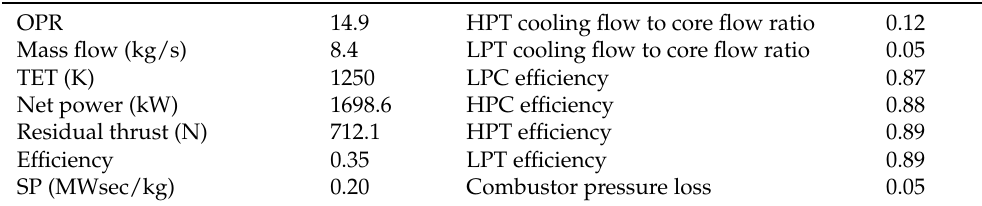
Table 4. Engine specifications at